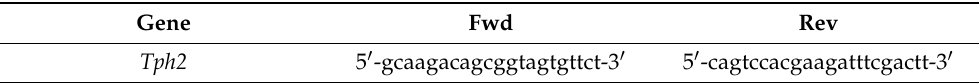
Table 1. Primers for RT-qPCR. Gene Fwd Rev Tph2 5 (cid:48) -gcaagacagcggtagtgttct-3 (cid:48) 5 (cid:48) -cagtccacgaagatttcgactt-3